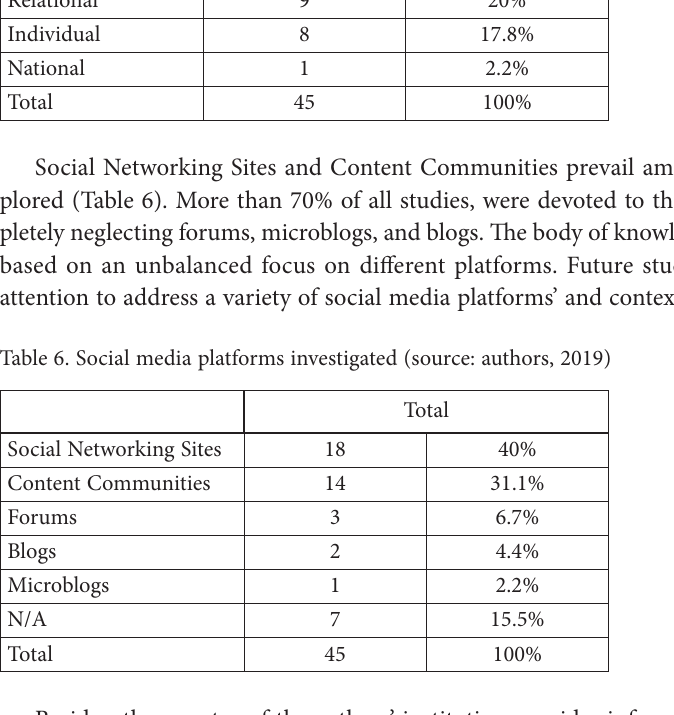
Table 5. Various levels of analysis (source: authors, 2019) Group 15 33.3%